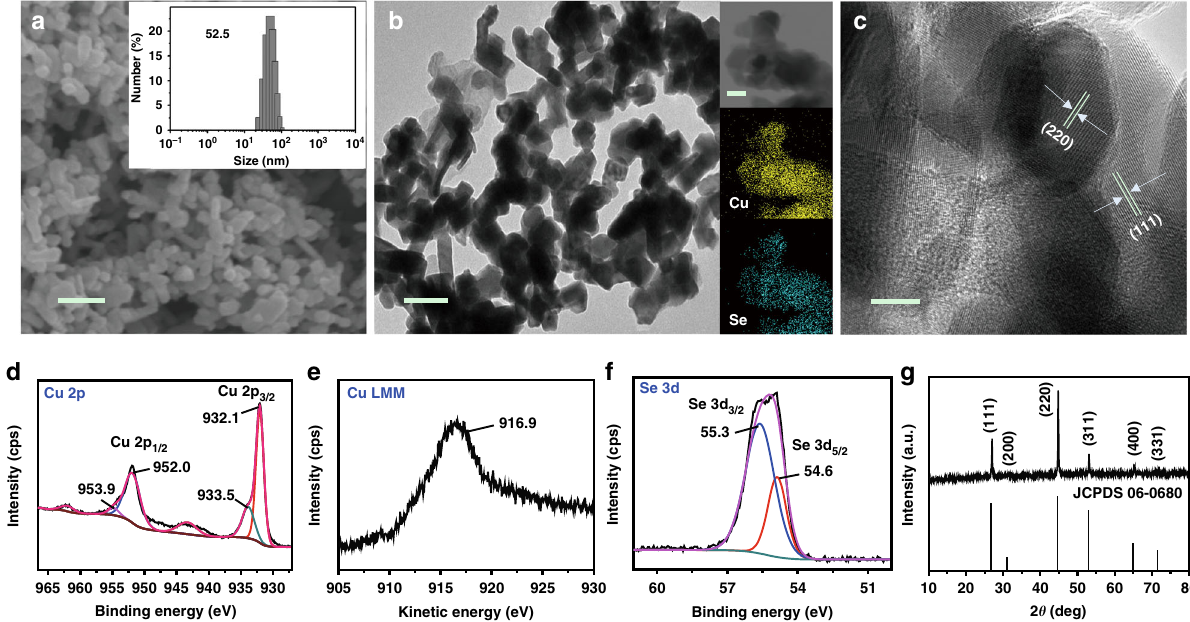
Fig. 1 Characterization of Cu 1.63 Se(1/3) nanocatalysts. a SEM image of the Cu 1.63 Se(1/3) nanocatalysts and the inset is size distribution determined by DLS, scale bar = 200 nm; b TEM image of the Cu 1.63 Se(1/3) nanocatalysts and the inset is the corresponding elemental mappings, scale bar = 100 nm; c HR- TEM image of the Cu 1.63 Se(1/3) nanocatalysts, scale bar = 10 nm; XPS spectra of the Cu 1.63 Se(1/3) nanocatalysts: d Cu 2p, e Cu LMM, and f Se 3d; g XRD patterns of the Cu 1.63 Se(1/3)